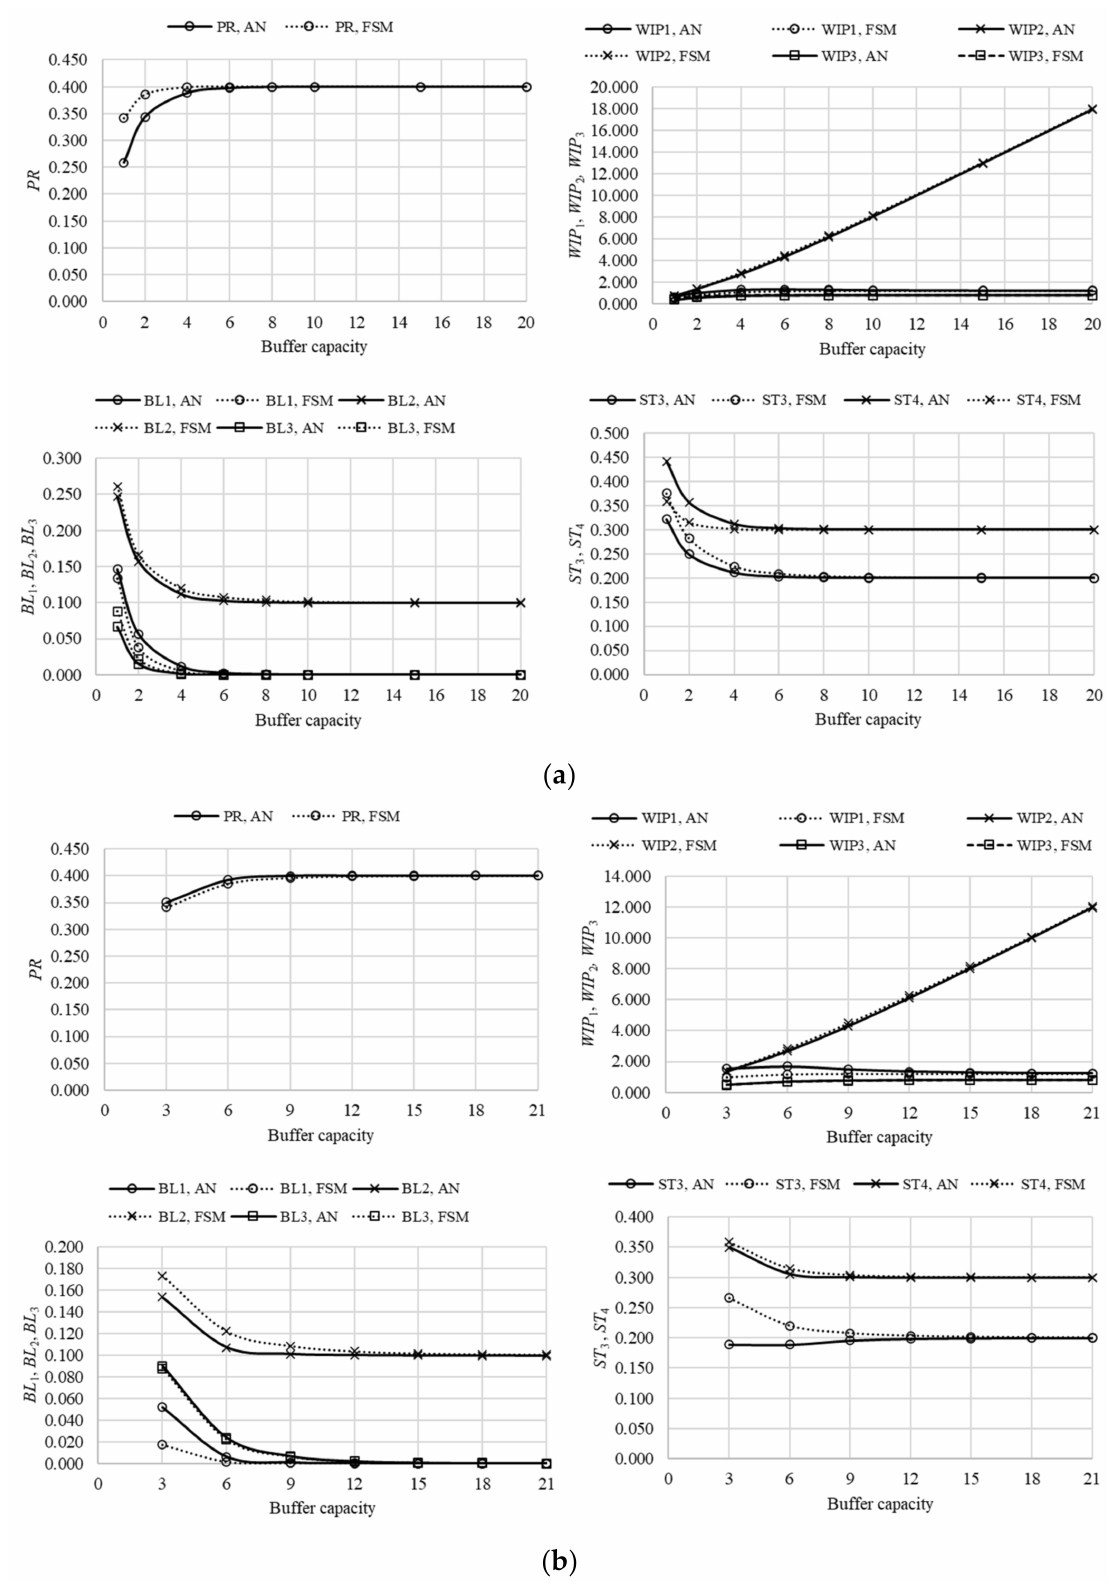
Figure 7. Comparison of the performance measures in the case of line L4B: ( a ) N 1 = N 2 = N 3 = N ; ( b ) N 1 = N , N 2 = 2 / 3 N , N 3 = 1 / 3 N